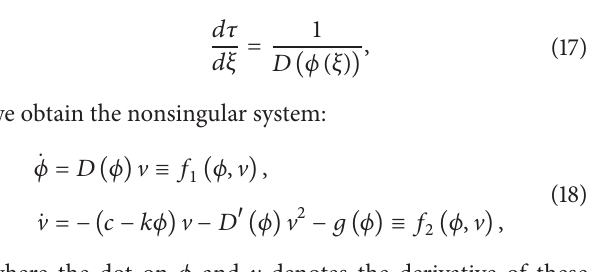
Figure 3: Approximation of the wave speed of the profiles evolving to a sharp traveling wave; to compute this we follow how the wave’s location changes with each time step. For a fixed value 𝑢 ≡ 0.5 we compute 𝑥 1 ,𝑥 2 ,... so that 𝑥 𝑖 is the 𝑥 , where 𝑢(𝑥,𝑡 𝑖 ) = 0.5 . We plot this curve versus time and compute the slope to approximate the wave speed and obtain 1.8 as a result. For these parameter values ( 𝛽 = 𝑘 = 1 ), the phase portrait numerical results show that the value of 𝑐 for which we have a unique heteroclinic connexion between 𝑃 1 and 𝑃 𝑐 is for 𝑐 ∗ ≈ 1.82